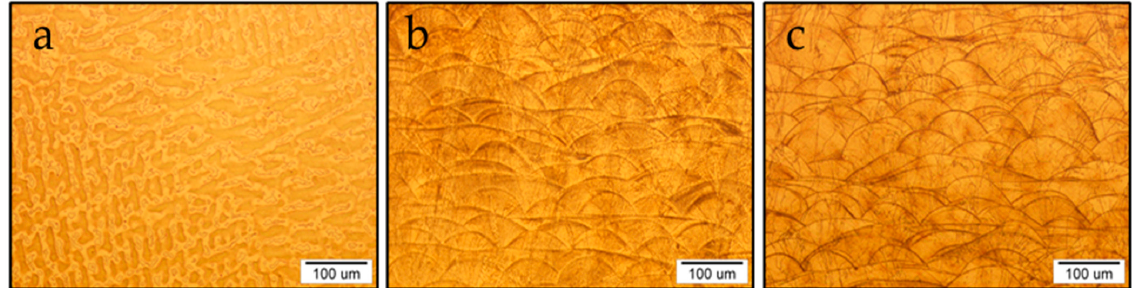
Figure 3. Optical microstructure of samples: ( a ) C, ( b ) S1 and ( c ) S3.